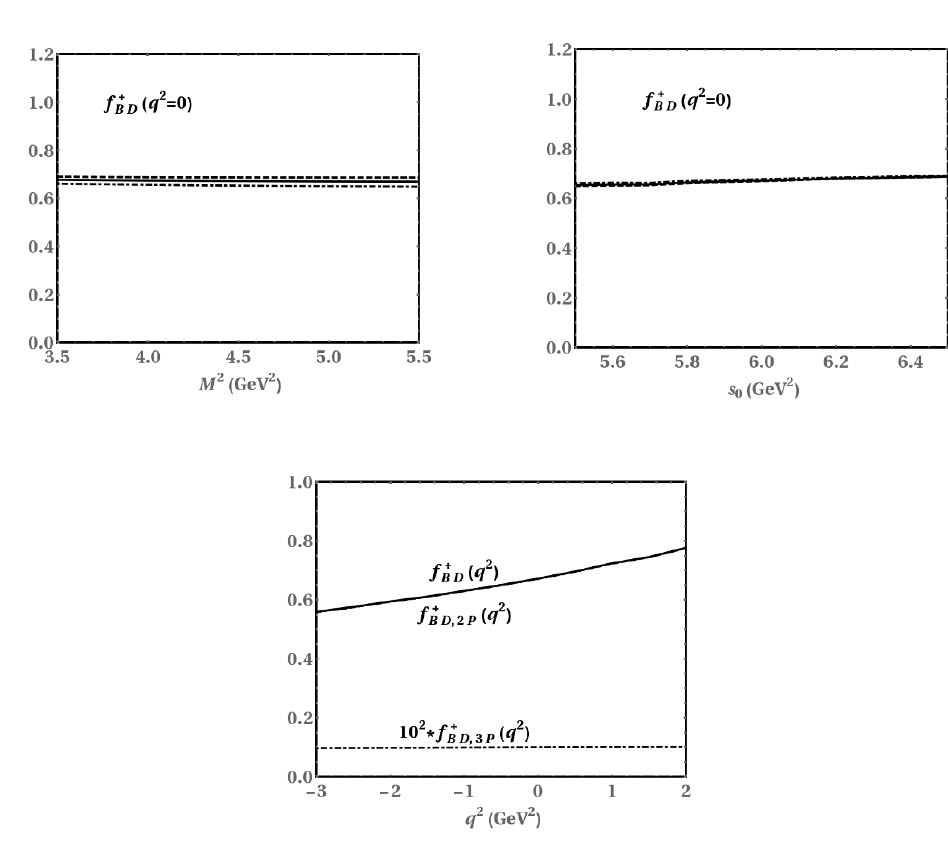
Figure 4 . Top: dependence of the vector form factor f + (0) on the Borel mass M 2 (left panel) and BD on the duality-threshold parameter s 0 (right panel) at (cid:21) B ( (cid:22) 0 ) = 570 MeV. The solid, dashed and dot-dashed curves are predicted from the LCSR (4.10) with s 0 = 6 : 0 GeV 2 , 6 : 5 GeV 2 and 5 : 5 GeV 2 (left panel), and with M 2 = 4 : 5 GeV 2 , 5 : 5 GeV 2 and 3 : 5 GeV 2 (right panel). Bottom: breakdown of the form factor f + (0) from the two-particle and from the three-particle contributions. The BD two-particle contribution to f + (0) indicated by the dashed curve is almost indistinguishable from BD the total result represented by the solid curve, due to the negligible e(cid:11)ect from the three-particle B -meson DA as shown by the dot-dashed